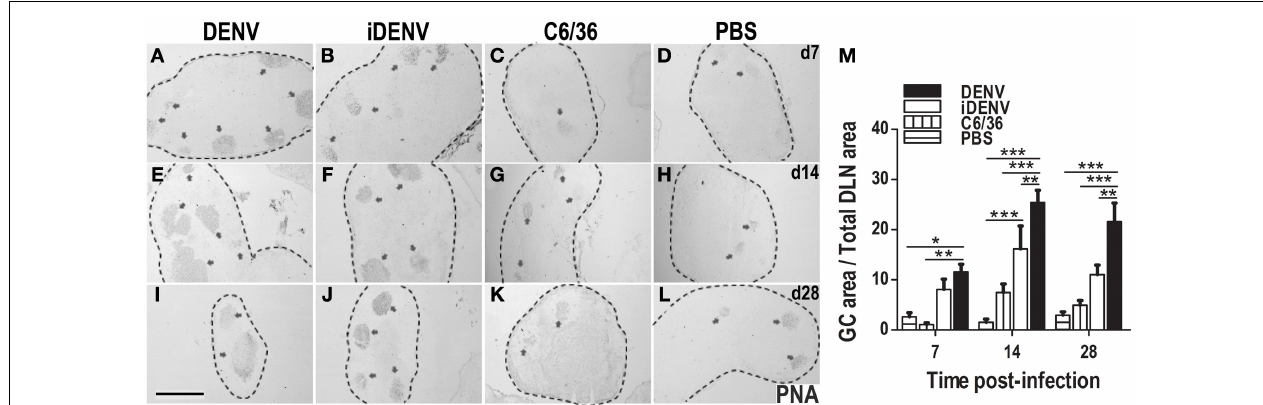
color (SG Vector). Representative pictures from one of three independent experiments are shown. Mice were inoculated at day 0 and boosted at day 7. (M) The kinetic of GCs area as percentage of GCs Area over Total LN Area in each condition is shown. Data shown are pooled from three independent experiments, represent the mean ± SEM, and were analyzed with two-way ANOVA with the Bonferroni post-test. * P < 0.05, ** P < 0.01, *** P < 0.001. Scale bar, 500 µ m.